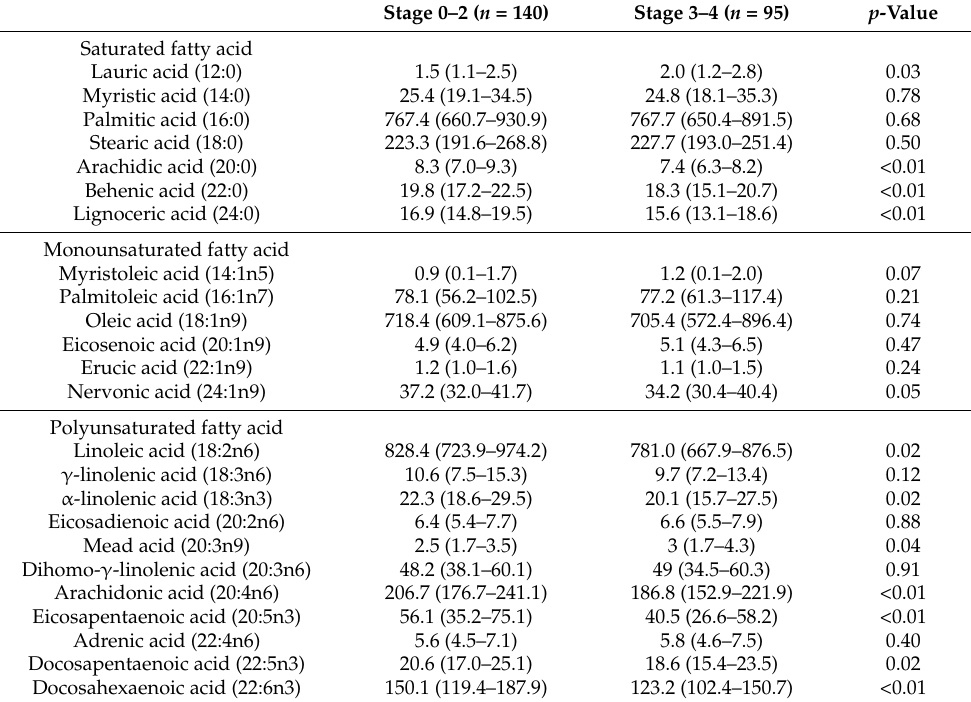
Table 5. Plasma fatty acid composition ( µ g/mL) (non-advanced fibrosis stage vs. advanced fibrosis stage).